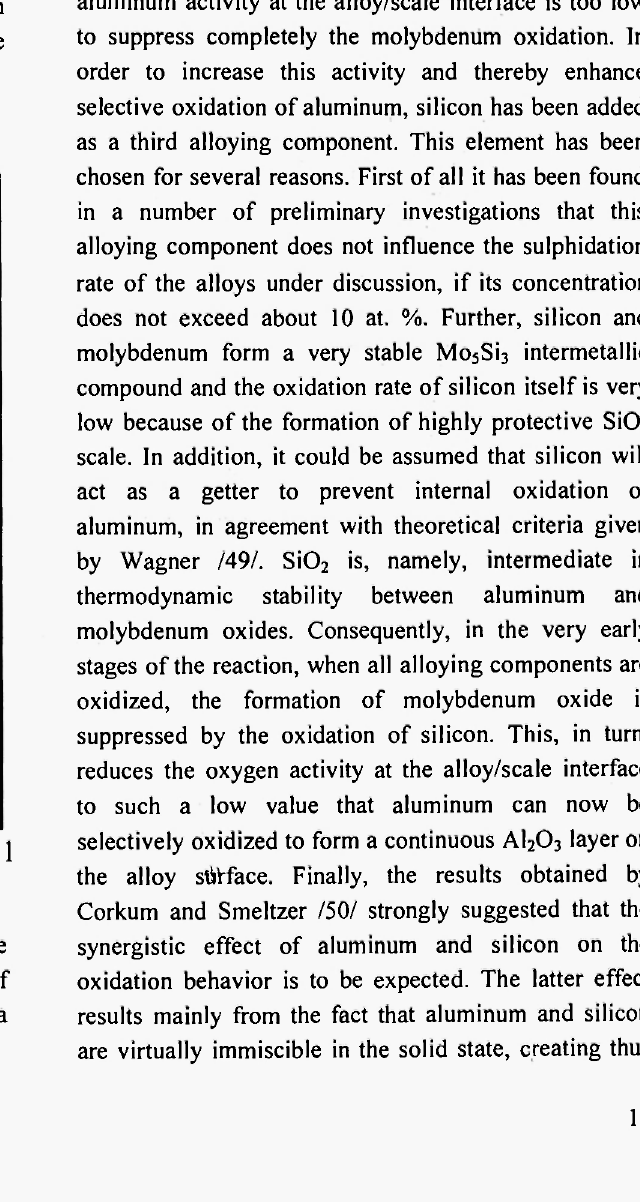
Temperature dependence of the oxidation rate for AI-34Mo alloy on the background of analogous dependence for several chrom'ia and alumina formers